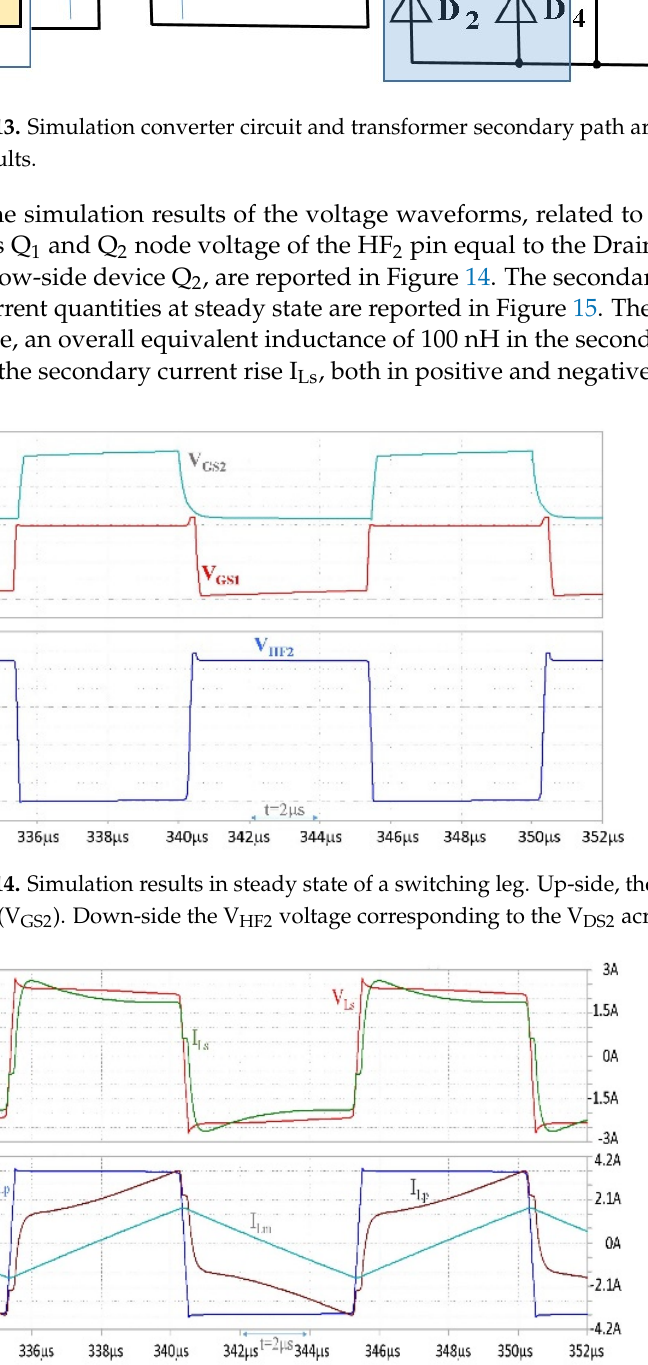
Figure 15. Simulation results in steady state. Up ‐ side, the current and voltage across the inductor in the secondary side (I Lp ,V Lp ) with magnetizing current I Lm . Down ‐ side secondary side electrical quantities (I Ls, V Ls ). Time t = 2 μ s/div.